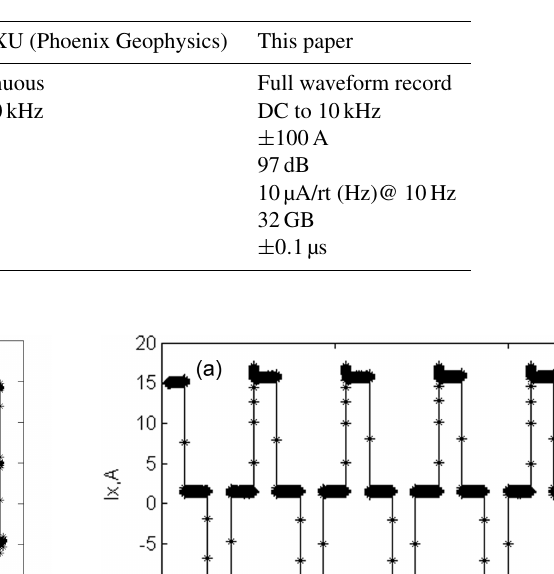
Table 4. Performance comparison with commercial current recorder from Phoenix Geophysics.